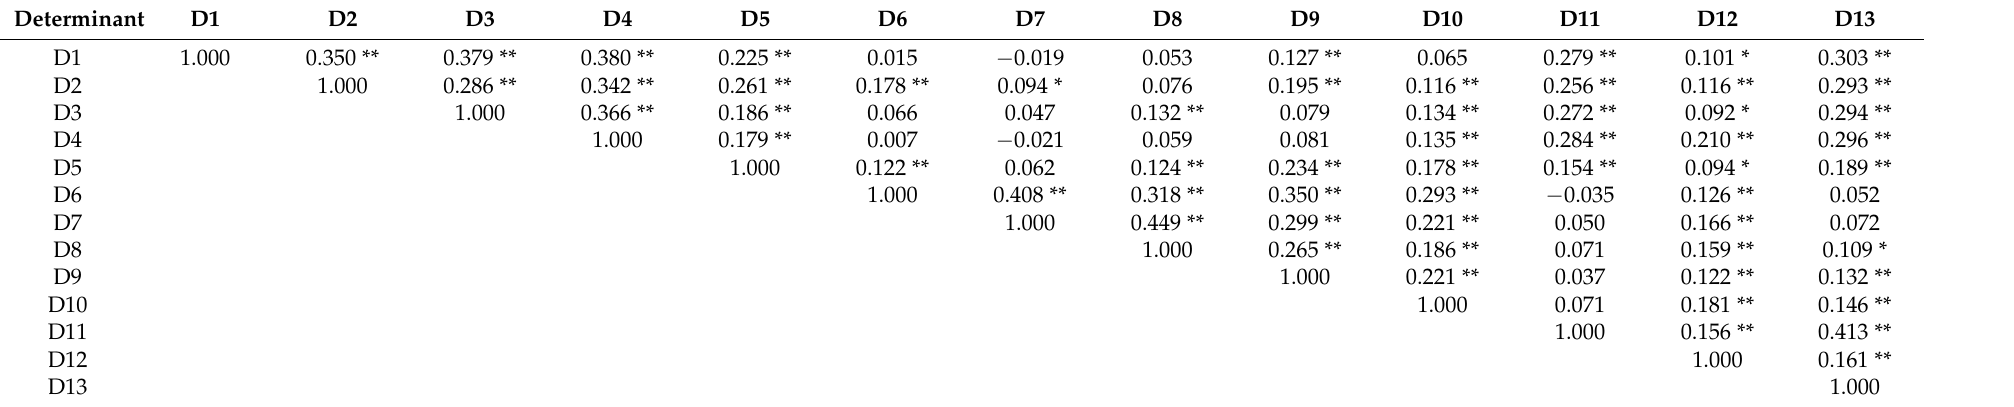
Table 2. Kendall’s tau-b correlation matrix of safety climate